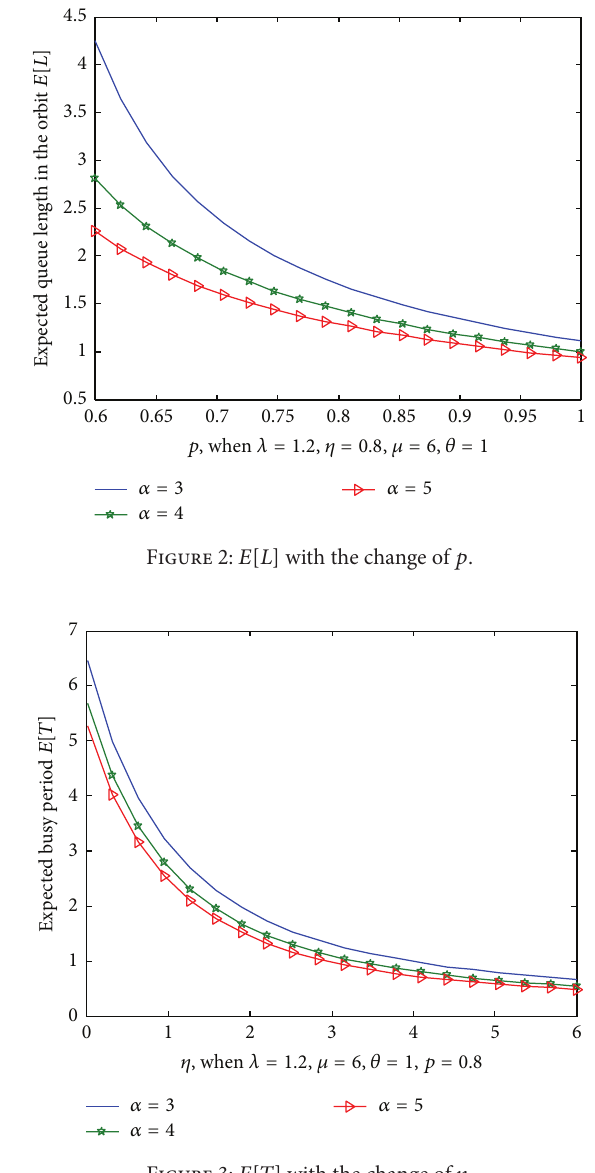
Figure 3: 𝐸[𝑇] with the change of 𝜂